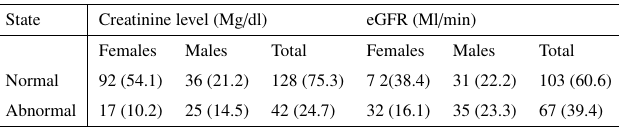
Table 2. Number of patients participate the study and their corresponding results according to gender. State Creatinine level (Mg / dl) eGFR (Ml / min)